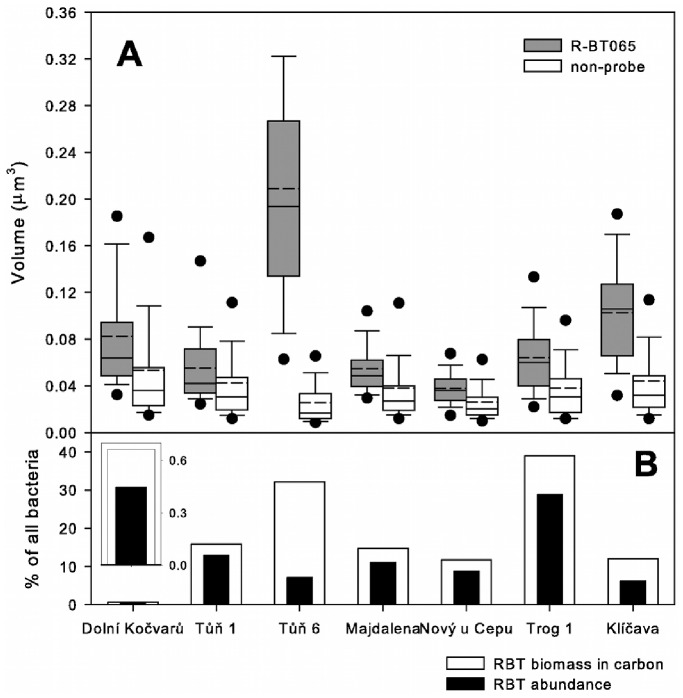
Biovolume of the R-BT065-positive-cells compared to other bacteria and their relative contribution in natural bacterial community.(A) Boxes represent 25% and 75% quartils, whiskers 5% and 95% quintiles, full circles outliers. Dashed lines represent means, whereas full lines are medians. (B) Relative proportions (%) of the R-BT065 bacteria targeted to total cells (black bar) and to total carbon biomass (white bar). Note that due to very low proportion of the R-BT bacteria in humic pond Dolní Kočvarů there is also incorporated a fine-scale resolution insert.